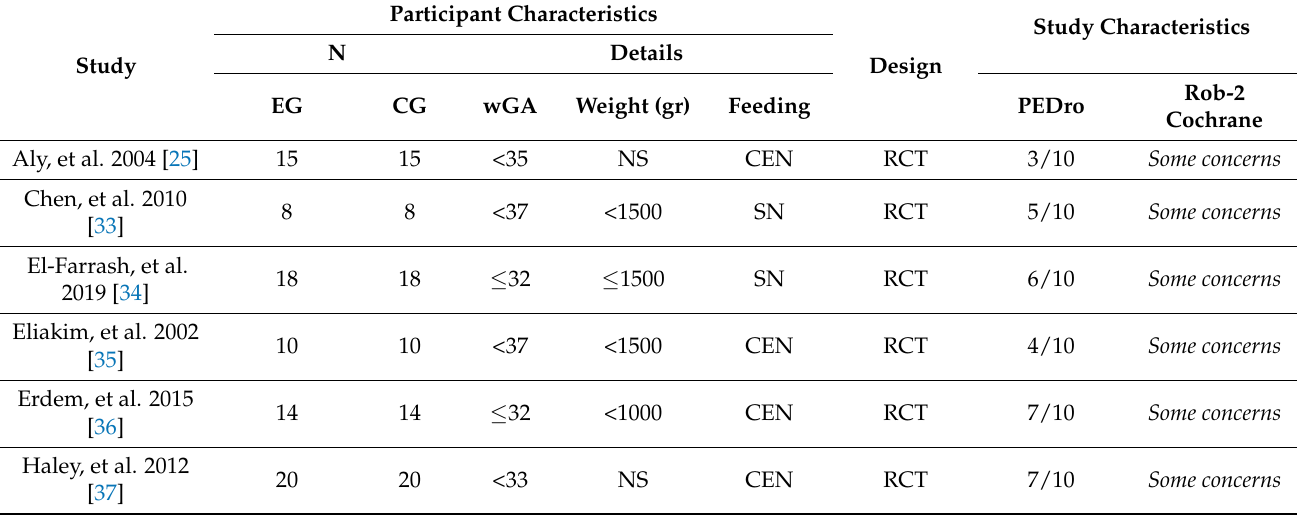
Table 1. Study and participant